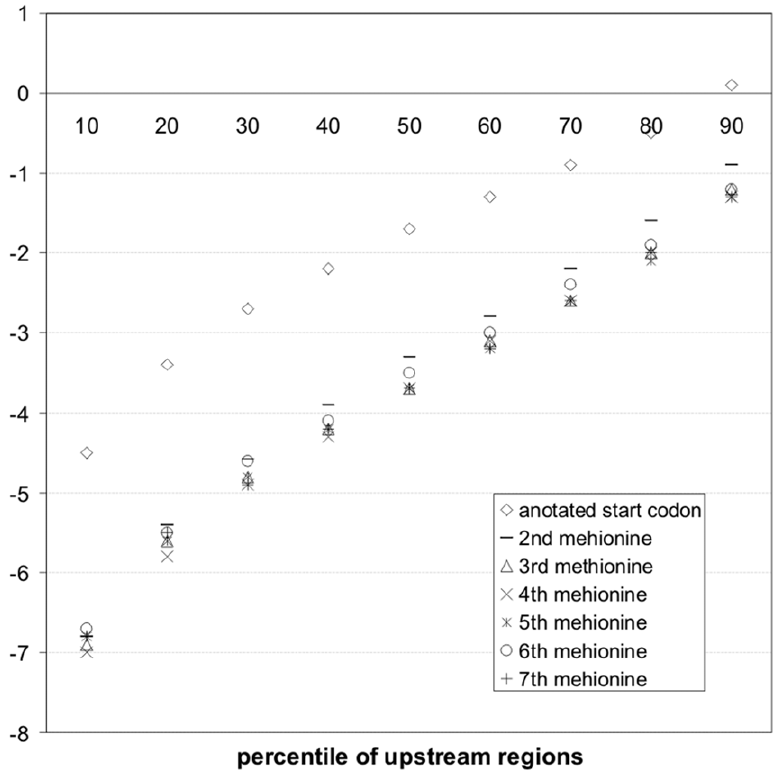
Figure 3. Folding energy distribution of start codon upstream regions in P.bryantii B 1 4 genome compared to distributions of successive methionine upstream regions.